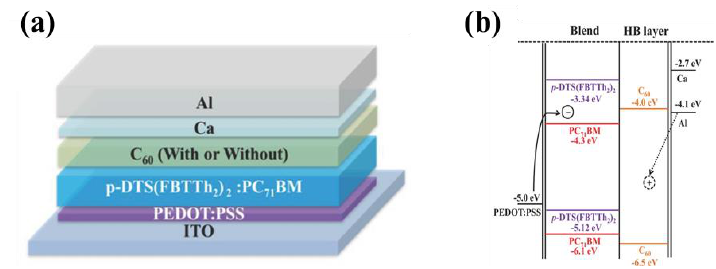
Figure 6. ( a ) Device architecture with and/or without a C 60 HBL using Ca/Al contact; ( b ) A simplified scheme for the process of dark carrier injection in an Al- and/or Ca/Al-containing photodiode under reverse bias with a C 60 HBL. (Reproduced with permission from [62]. WILEY Publishing,